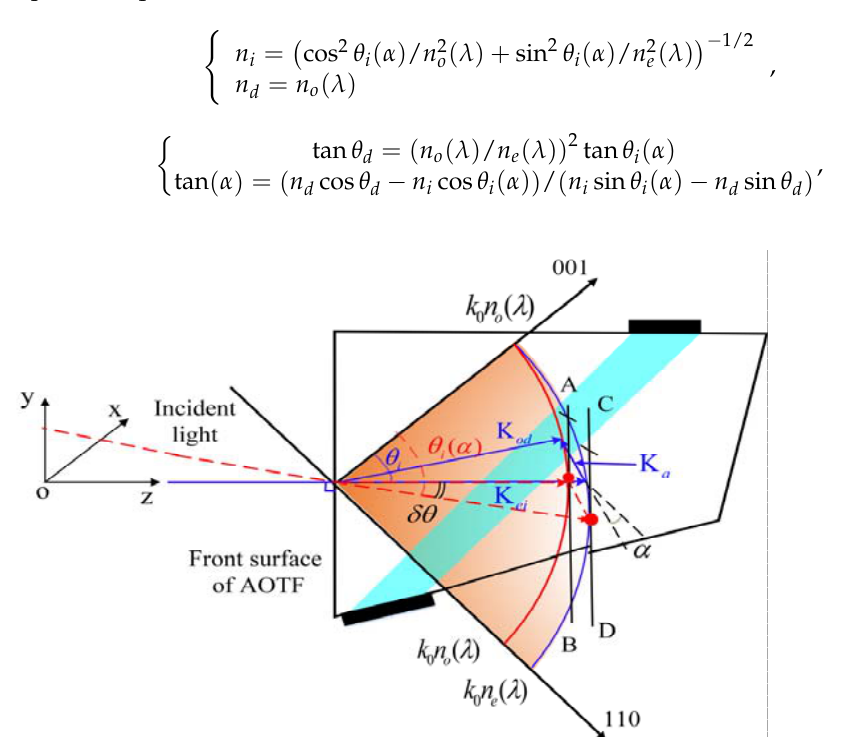
Figure 1. Wave vector layout under the parallel tangent principle (e → o mode). K ei , incident light is extraordinary; K od , diffracted light is ordinary; K a , acoustic vector; oy , the direction of acousto-optic diffraction.